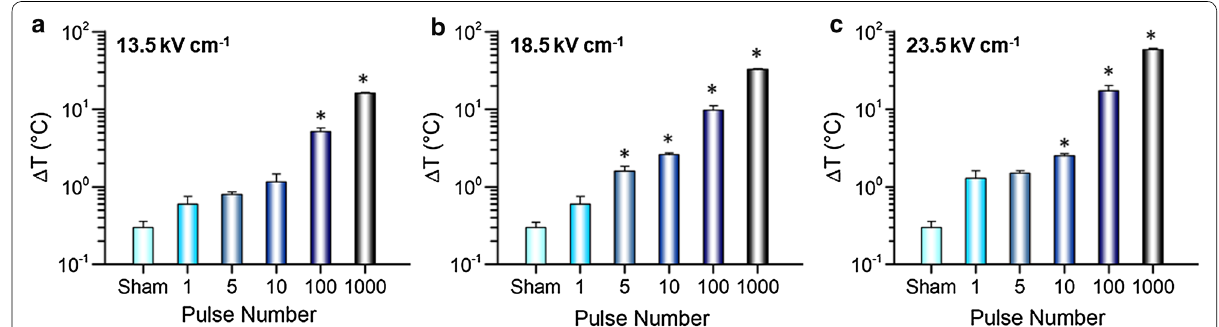
Fig. 2 nsPEF induced temperature change. Temperature change (ΔT) (°C) of 0.85% NaCl cell solution exposed to a 600-ns PEF at 13.5 ( a ), 18.5 ( b ) or 23.5 ( c ) kV cm − 1 at 0 (sham), 1, 5, 10, 100 or 1000 pulses. Results are the mean a statistically significant difference from the